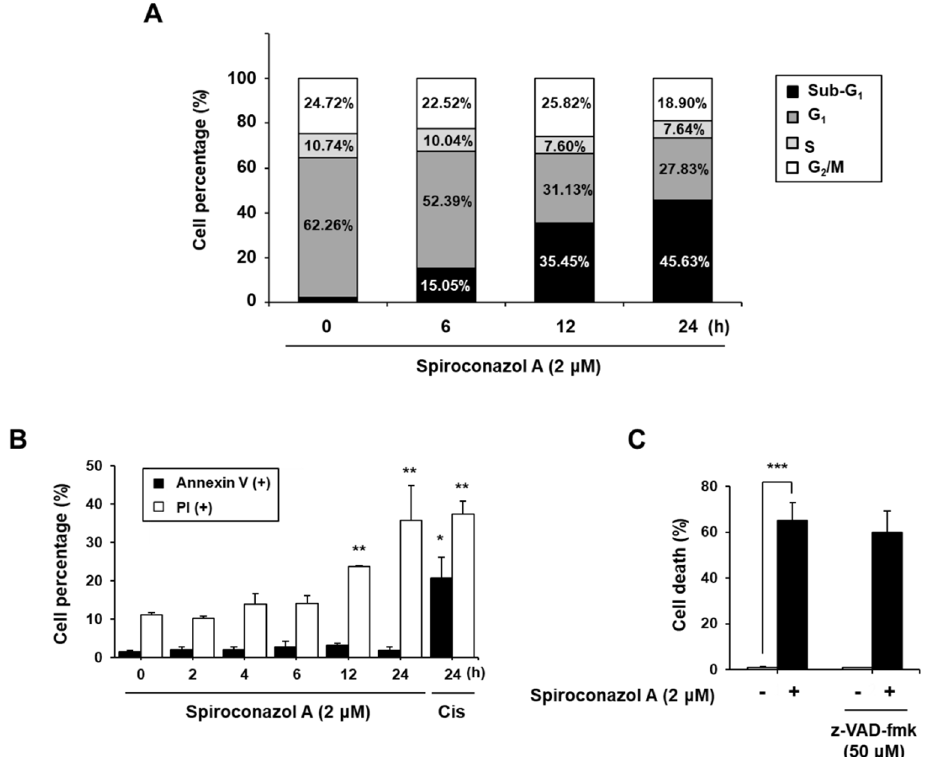
Figure 1. Non-apoptotic features were presented by spiroconazol A in A549 cells. ( A ) Cells were exposed to spiroconazol A (2 μ M) and were stained with the PI solution. For detection of sub-G 1, indicating cell death, cells were determined by flow cytometry. ( B ) After treatment with spirocona- zol A (2 μ M) for the indicated times, cells were stained with FITC-conjugated Annexin V and PI (Cis: cisplatin) and then detected by flow cytometry. ( C ) After treatment with 50 μ M z-VAD-fmk (broad caspase inhibitor) for 1 h, cells were treated with spiroconazol A (2 μ M) for 24 h. Cells were stained with the PI solution and then examined by flow cytometry. Experiments were repeated at least three times, and data are expressed as mean ± S.D. * p < 0.05, ** p < 0.01, and *** p < 0.001 vs. control group by the Student’s t -test. 2.3. Spiroconazol A Induces Autophagy in A549 and NCI-H358 Cells To better understand the caspase-independent cell death induced by spiroconazol A, we investigated other cellular responses related to cell death following spiroconazol A treatment. As shown in Figure 2A, compared with the control, spiroconazol A showed morphological features of cytoplasmic vacuole accumulation, unlike apoptotic bodies, and markedly decreased cell density. In particular, spiroconazol A treatment increased the size and number of cytoplasmic vacuoles compared with those in the control. Based on these morphological differences, we speculated that spiroconazol A-induced cytoplas- mic vacuoles might be the products of autophagosome formation. In this regard, we de- tected autophagy-related protein expression using Western blot analysis. As shown in Figure 2B, treatment with 2 μ M spiroconazol A markedly and time-dependently upregu- lated the protein expression levels of LC3-II and Beclin-1 in A549 and NCI-H358 cells. Previous studies reported that Bcl-2 family proteins interact with an evolutionarily con- served autophagy protein, Beclin-1, under normal conditions. However, under external conditions, the dissociation of Bcl-2 family proteins from Beclin-1 contributes to the in- duction of autophagy [14]. Our results showed that spiroconazol A (2 μ M) treatment markedly reduced the expression levels of Bcl-xL, but not Bcl-2, in A549 and NCI-H358 cells (Figure 2B). These results suggest that Bcl-xL participates in the induction of au- tophagic cell death by spiroconazol A by dissociation from Beclin-1.